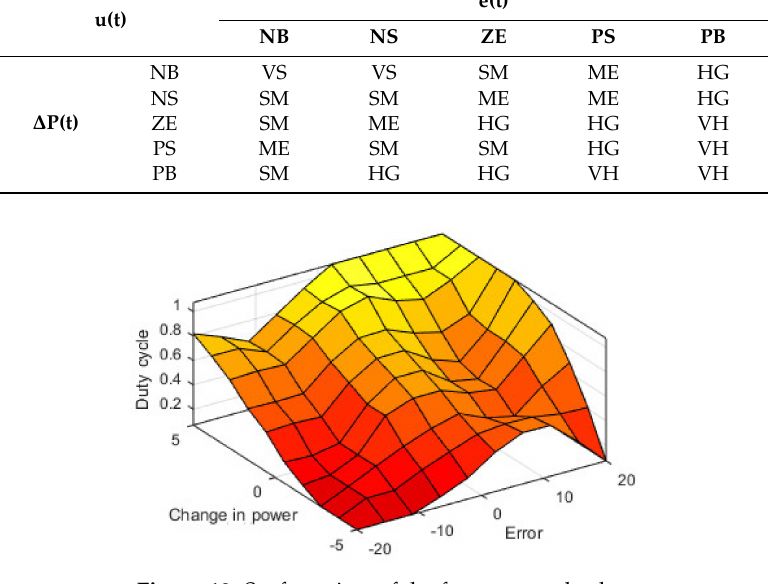
Figure 10. Surface view of the fuzzy control rules. Table 3. Electrical parameters of the converter circuit.